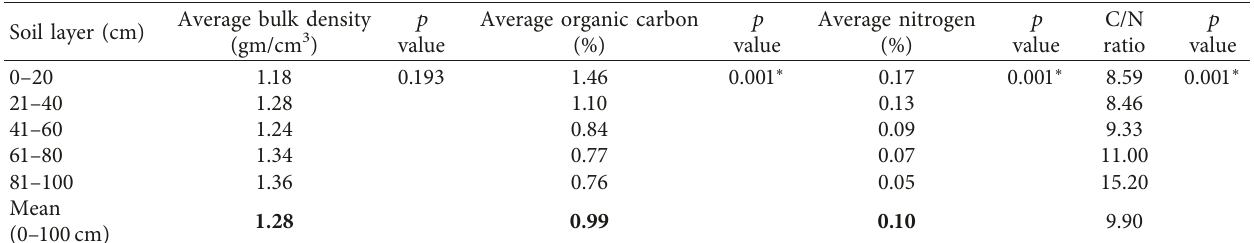
Figure 1: Kankali community forest (source: Table 1: Bulk density, organic carbon, nitrogen, and C/N ratio in different soil layers.